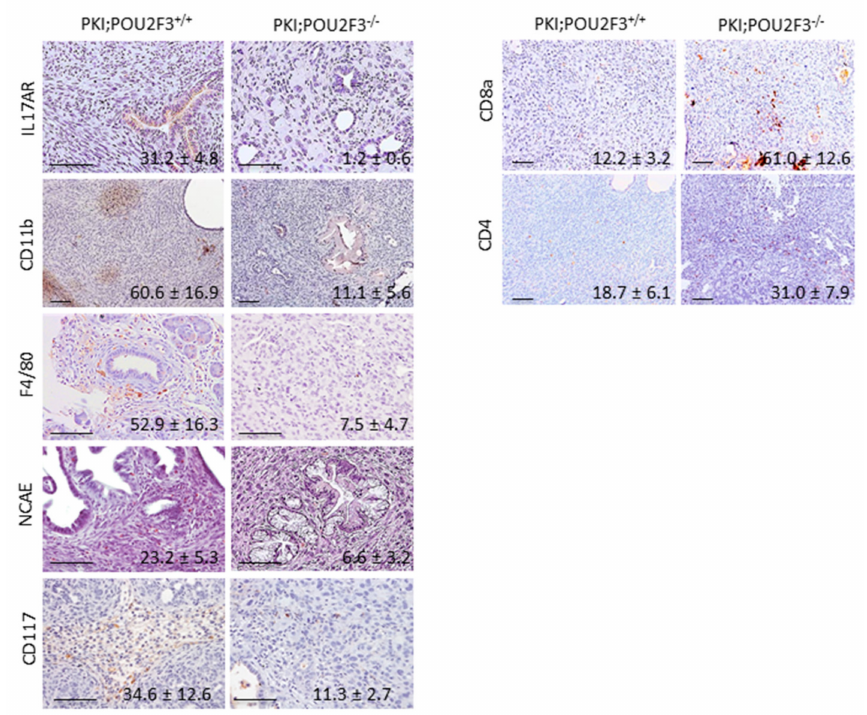
Figure 4. Immunological infiltration in PDAC. Immuno-staining of sections from pancreatic tumors. Values denote positive cells per field. Scale set as 100 µ